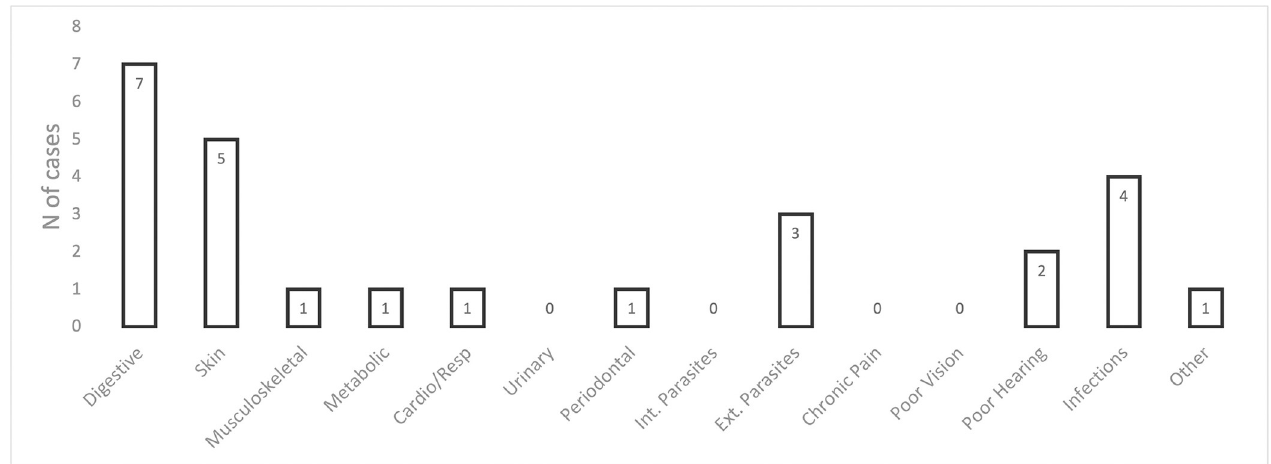
Fig 5. Physical health of rehomed dogs. Number of cases of health concerns reported by owners during the first month after adoption (n = 32).